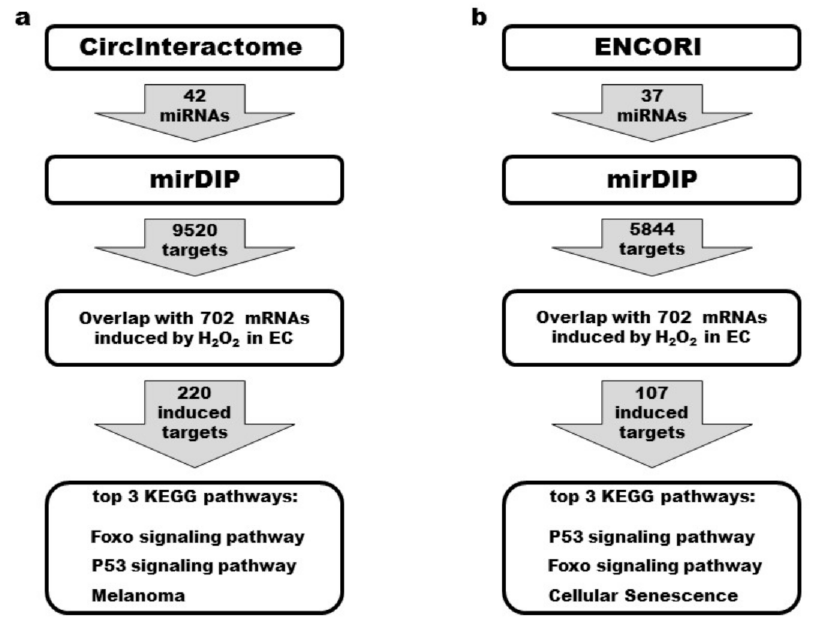
Figure 7. Pipelines for investigating circRNA–miRNA–mRNA networks of circANKRD12. Two different prediction tools identified miRNA binding sites for circANKRD12. ( a ) Circular RNA Interactome, based on the TargetScan prediction algorithm and ( b ) ENCORI, supported by Ago CLIP-seq experiments. Predicted targets identified by mirDIP were intersected with mRNAs found to be induced upon exposure to 16 or 36 h of H 2 O 2 in HUVEC (GSE104664). KEGG-enriched pathways of the identified targets were ranked by